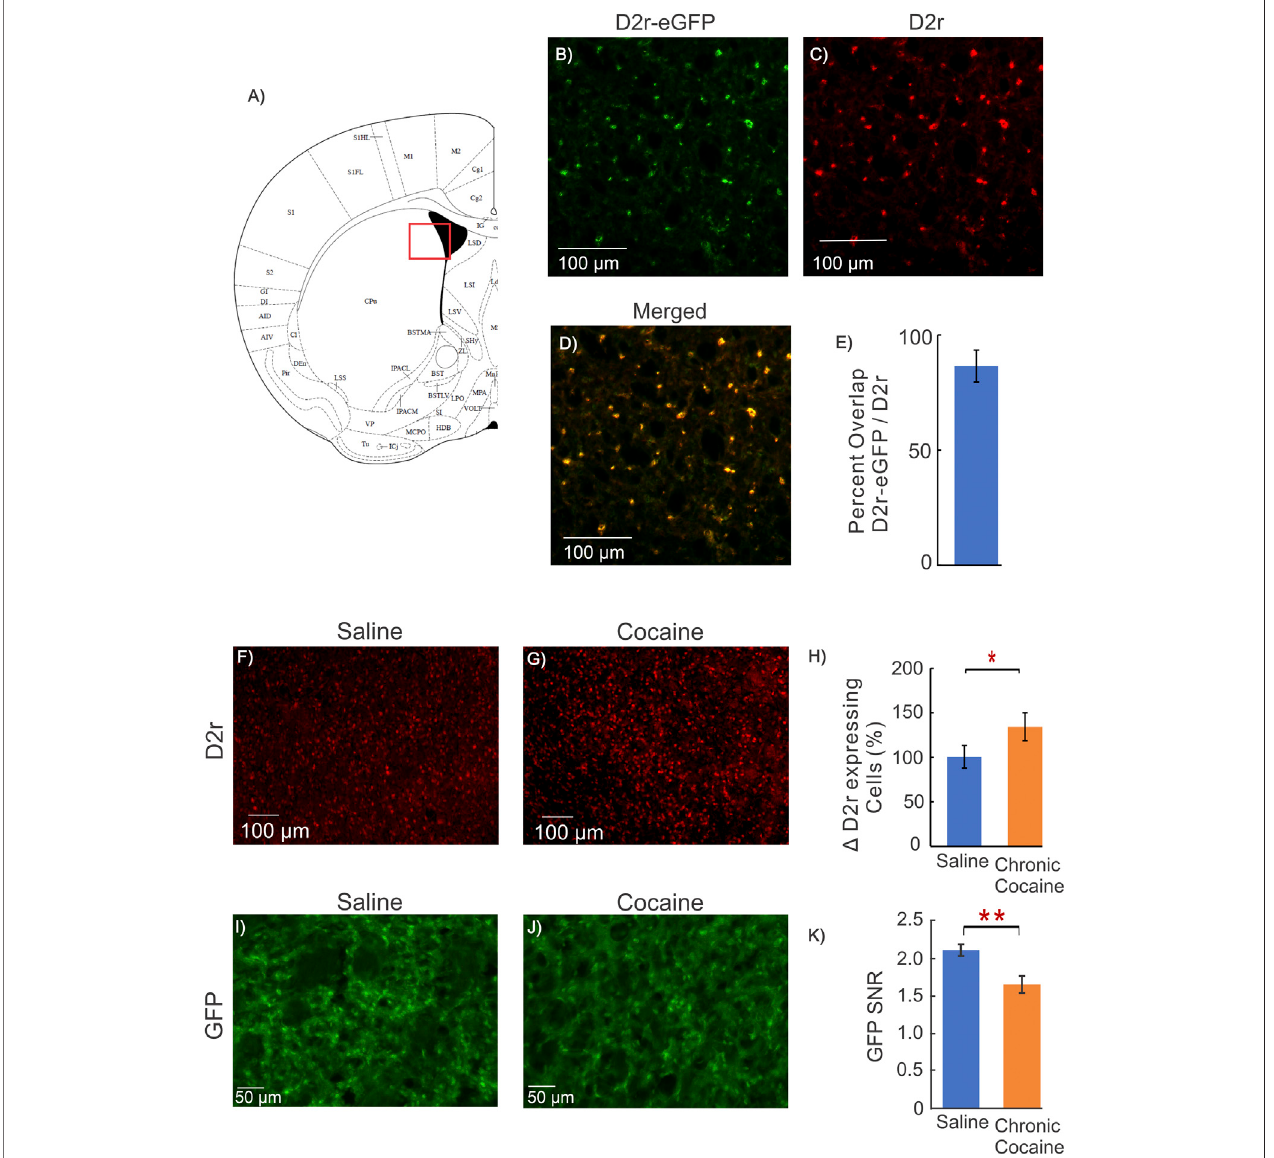
FIGURE 4 | Dstr D2r Response in Cocaine WT mice and fl uorescent intensity measure. (A) : Mouse brain atlas showing location of imaging in (George and Franklin, 2001); (B – D) : Representative images from a mouse brain of the co-localization of GFP from D2r-eGFP reporter line (green), D2r antibody (red), and merged (yellow) obtained from the dorsal striatum; (E) : Quanti fi cation of overlap of GFP and D2r antibody, indicating that GFP of the D2r-eGFP transgenic mouse reports cellular D2r expression; (F, G) : Representative images of D2r positive cell density in the dorsal striatum of a WT animal obtained using an antibody directed against D2r for a control (saline) and cocaine mouse; (H) : Quanti fi cation of the density of D2r-positive cells for 3 saline and 3 cocaine treated C57BL/6 male mice, indicating the D2r-neuronal expression increase after chronic cocaine exposure (p (cid:2) 0.02); (I – J) : Representative images of ex-vivo GFP expression without immunohistochemistry from a control and a cocaine treated animal; (K) : Comparison of GFP Signal-to-Noise Ratio (SNR (cid:2) GFP expression per D2r neuron/background noise) between control and cocaine treated mice. The GFP of D2r neurons in cocaine treated mice (1.66 ± 0.08, n (cid:2) 6, m (cid:2) 25) was signi fi cantly lower than in controls (2.11 ± 0.05, n (cid:2) 5, m (cid:2) 18, p (cid:2) 0.002, Student t-test). Blue bars correspond to saline and orange bars to chronic cocaine. Values are means and